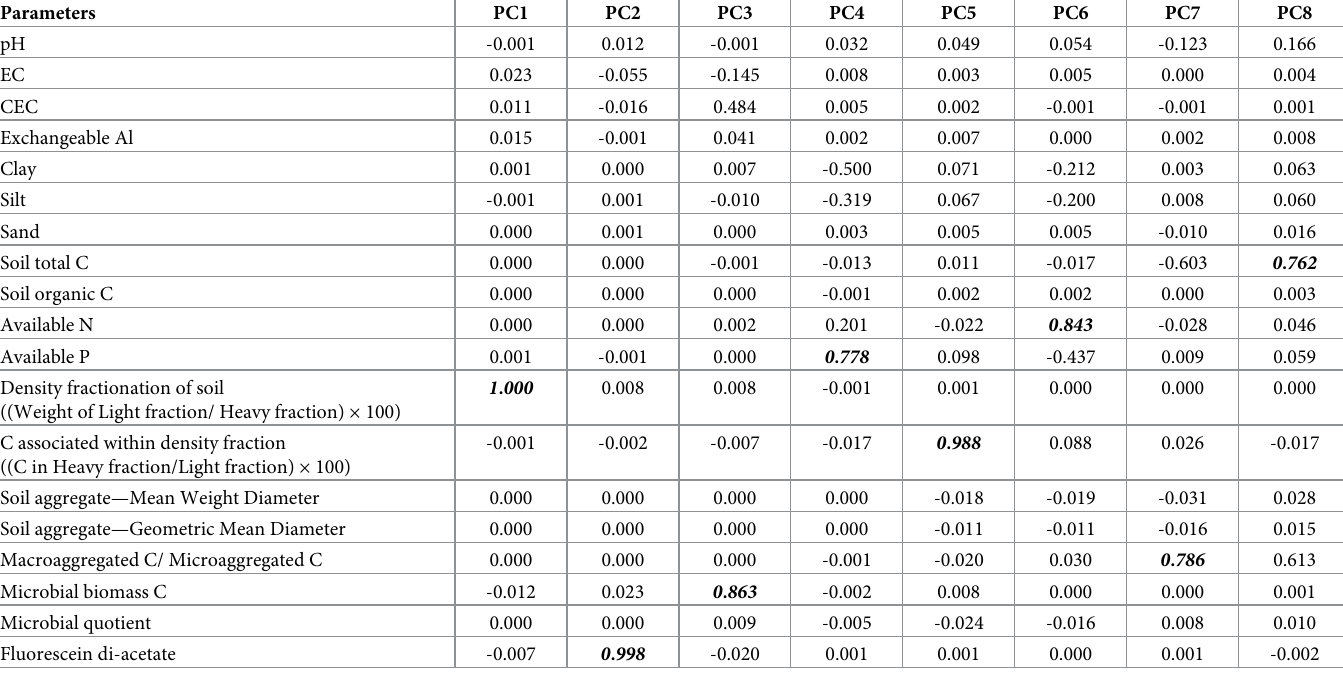
Table 2. Selection of parameters (indicators) for soil quality index using eigenvectors obtained through principal component analysis. Parameters